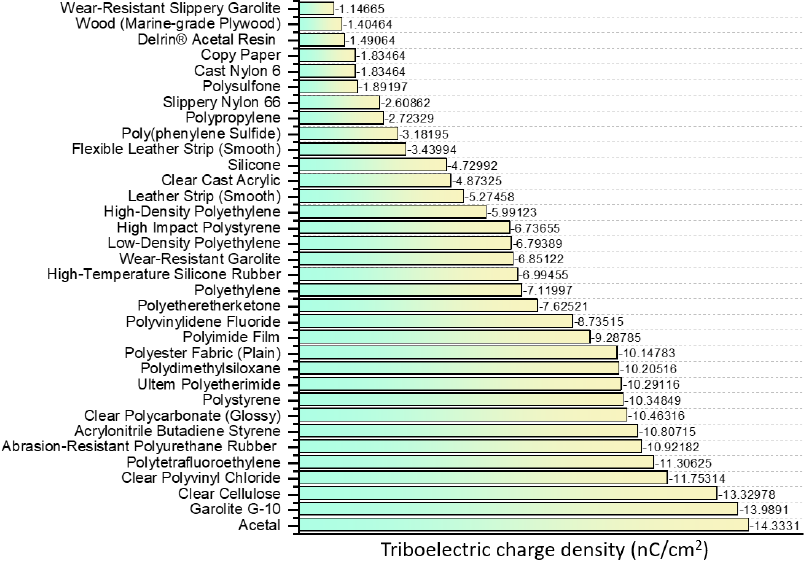
Figure 5. Familiar materials used for triboelectric and their triboelectric charge density [106].